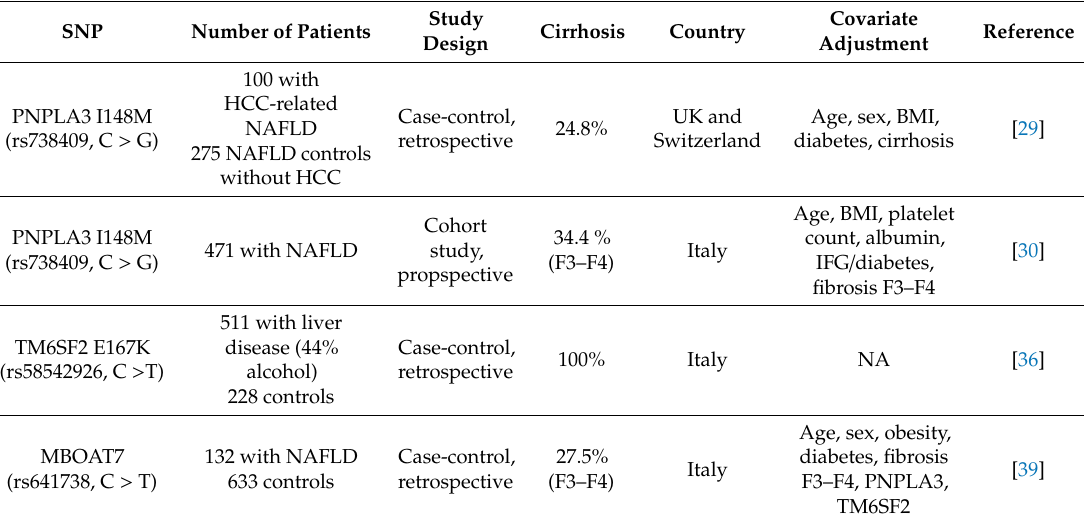
Table 1. Genetic findings associated with NAFLD-related